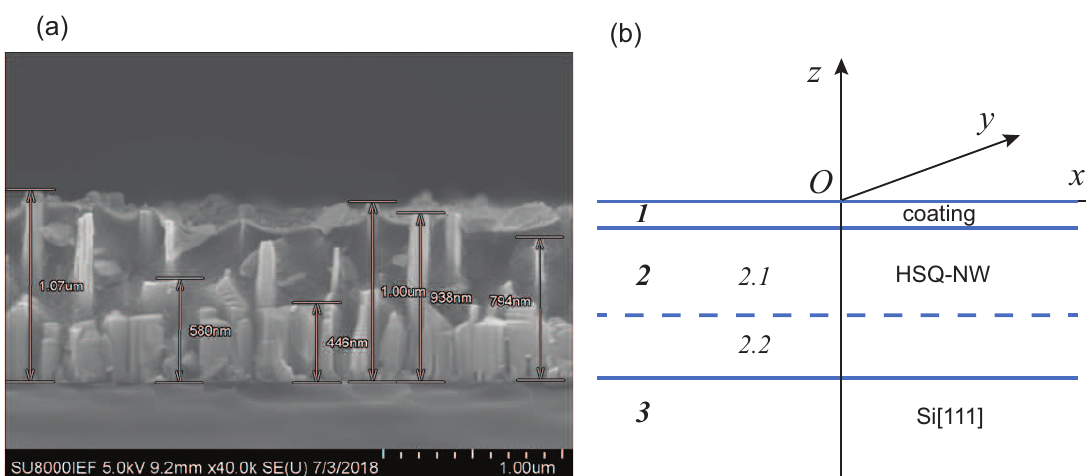
Figure 5. ( a ) Electronic microscope picture of the cross-section of the cleaved specimen. Here, NWs are embedded into HSQ matrix, Cr/Pt metal electrode is deposited on the top. ( b ) Coordinate system for a multilayered elastic half-space used to model SAWs; dashed line is for a further subdivision in accordance with vertical inhomogeneity of the HSQ-NW layer.